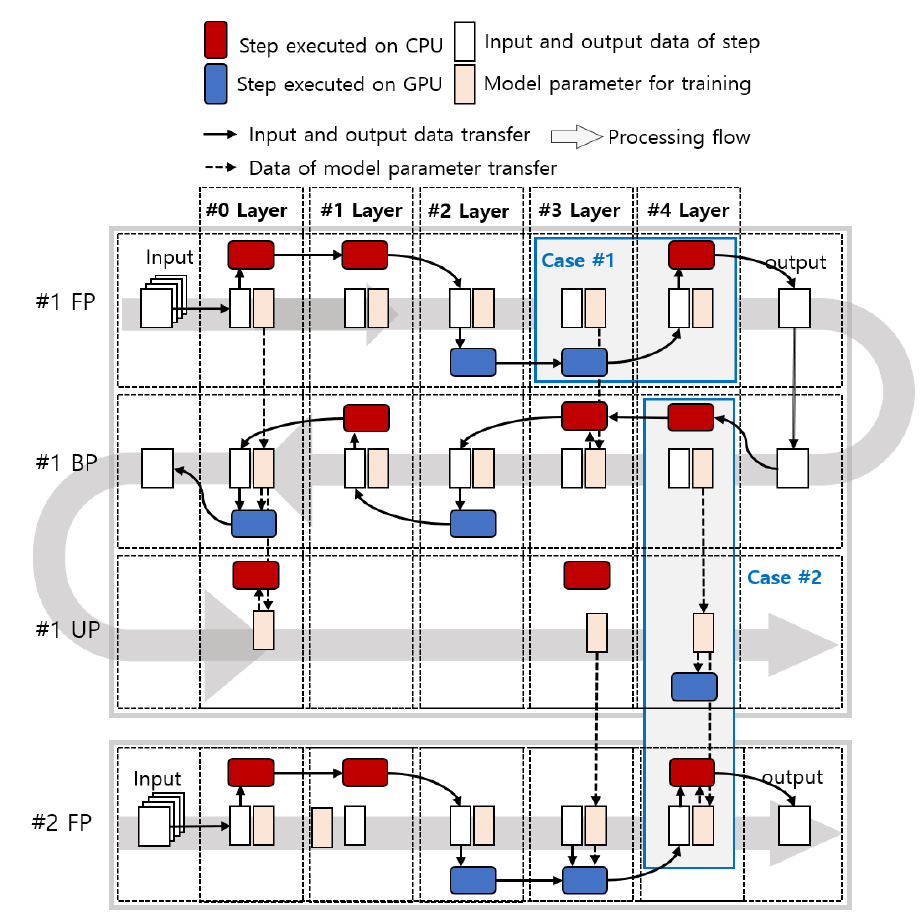
Figure 3. Illustration of the on-device learning with data